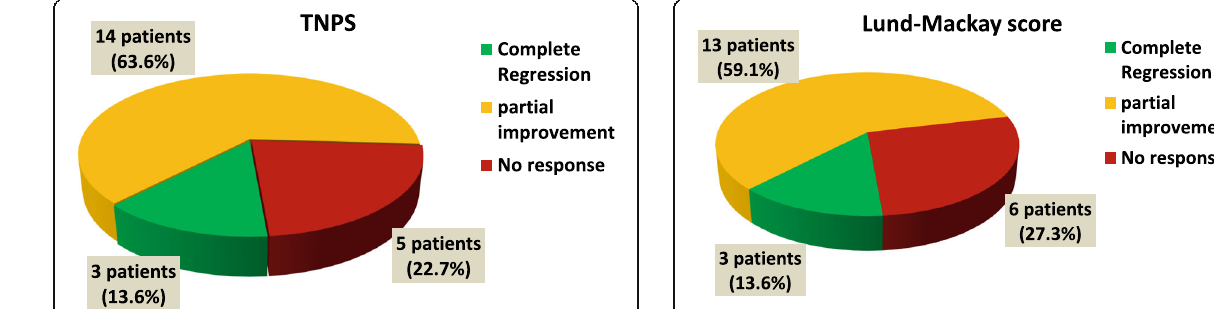
Fig. 3 Pie chart showing the effect of injection on Lund-Mackay score